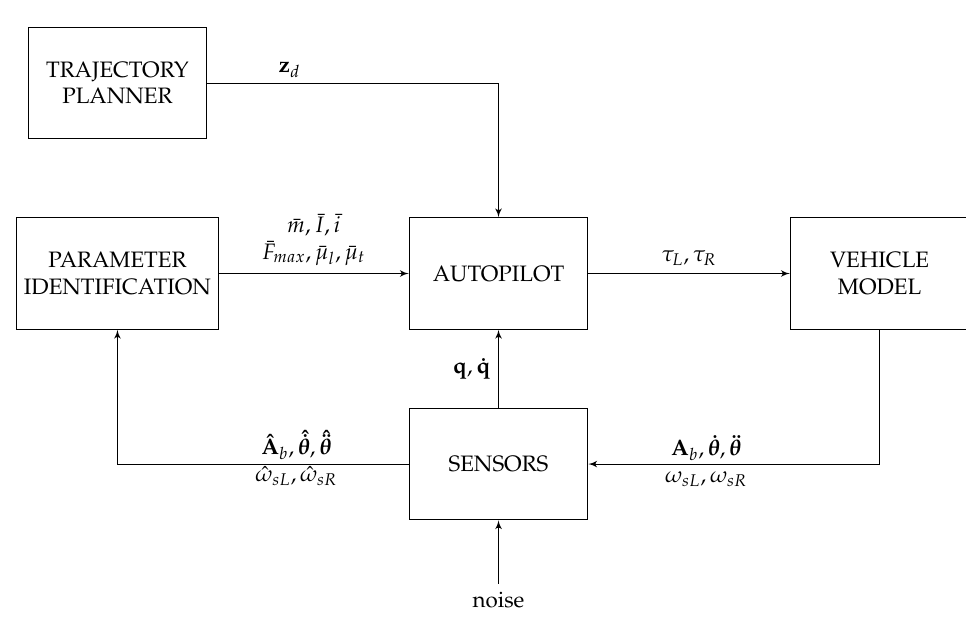
Figure 6. Block diagram of the tracked vehicle